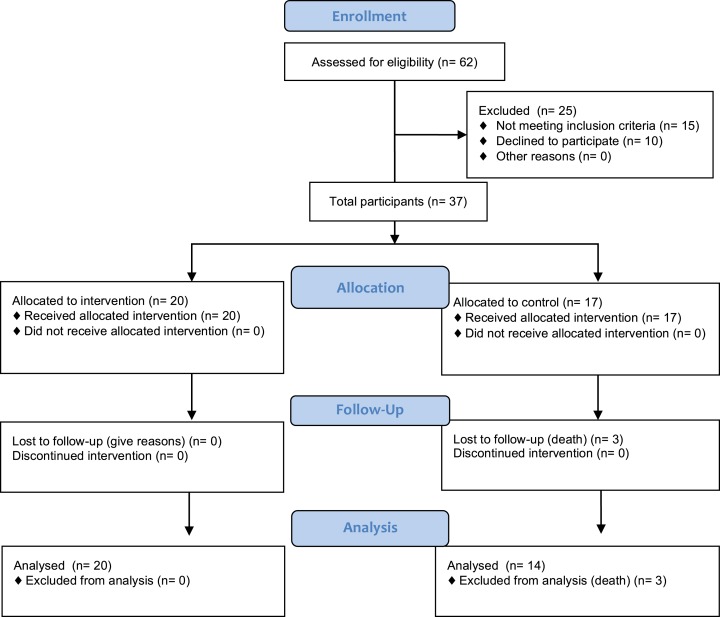
Project CONSORT diagram of recruitment and assessment of study participants.Enrolment numbers and withdrawals, or those lost to follow-up, are indicated in the boxes.